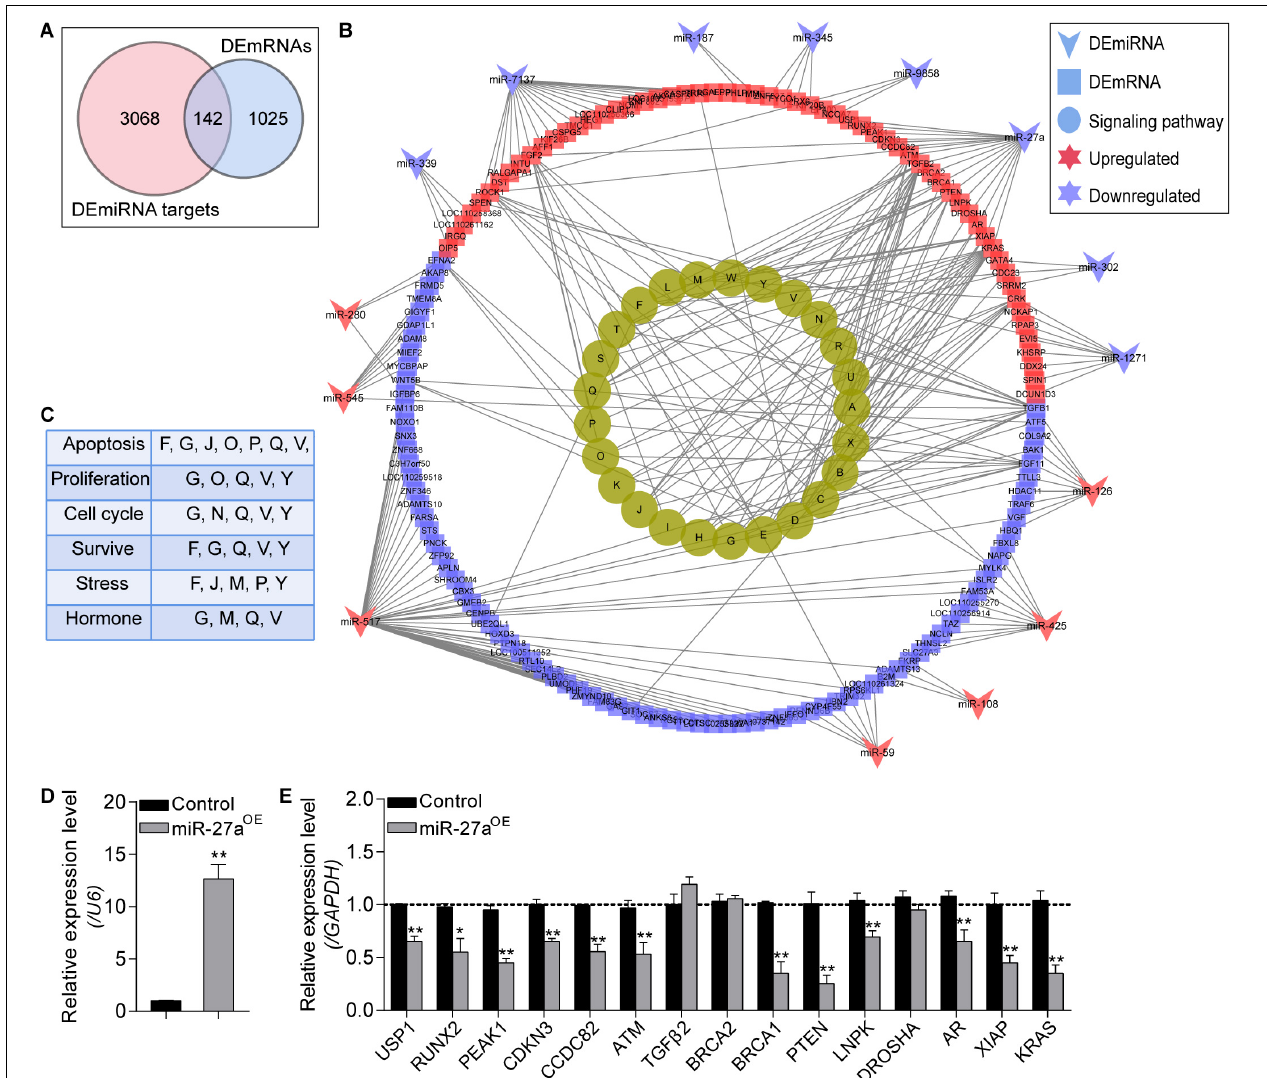
FIGURE 6 | Identification of the NORFA -mediated DEmiRNA–DEmRNA network. (A) Venn diagram showing the common genes that simultaneously belong to the DEmRNAs and the validated target genes of DEmiRNAs. (B) DEmiRNA–DEmRNA pathway network. Arrows indicate DEmiRNAs, squares indicate DEmRNAs, and circles represent the most significant signaling pathways ( P < 0.05). The colors depict the changes of the expression patterns (red and purple indicate up- and down-regulated). The identified KEGG pathways were as follows: A, pathways in cancer; B, regulation of actin cytoskeleton; C, microRNAs in cancer; D, HTLV-I infection; E, proteoglycans in cancer; F, ubiquitin mediated proteolysis; G, MAPK signaling pathway; H, renal cell carcinoma; I, melanoma; J, FoxO signaling pathway; K, chronic myeloid leukemia; L, toxoplasmosis; M, focal adhesion; N, cell cycle; O, Rap1 signaling pathway; P, Ras signaling pathway; Q, PI3K-Akt signaling pathway; R, leishmaniasis; S, pancreatic cancer; T, hepatitis B; U, colorectal cancer; V, TGF- β signaling pathway; W, small cell lung cancer; X, prostate cancer; Y, NF-kappa B signaling pathway. (C) The NORFA -mediated pathway–function interactions were analyzed. (D) The expression level of miR-27a in porcine GCs treated with miR-27a mimics was detected by qRT-PCR ( n = 3). (E) The interactions between miR-27a and its potential targets within the DEmiRNA–DEmRNA regulatory network were measured by qRT-PCR ( n = 3). Data in (D) and (E) were presented as mean ± S.E.M. with three independent replicates, and P values were calculated by a two-tailed Student’s t test. * P < 0.05 and ** P <